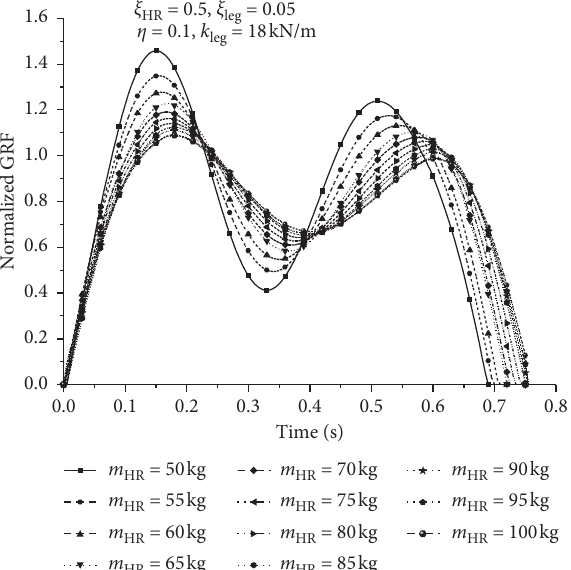
Figure 24: Peak damping ratio under leg stiffness 15.96kN/m, � 0 . 05. η � 0 . 3, and ξ leg